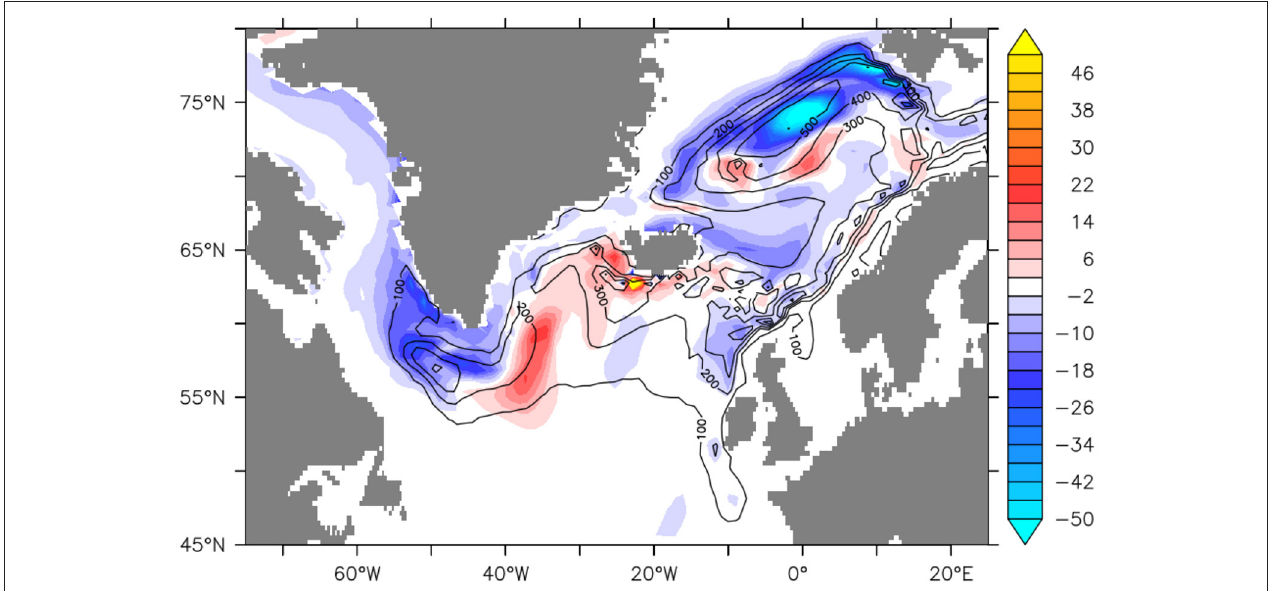
FIGURE 6 | MLD anomalies in LR simulations (in meters) averaged over the 20 members and over the 95 years of simulation and in January–February–March. The mean state of the control simulation averaged over the same period is shown in contour.